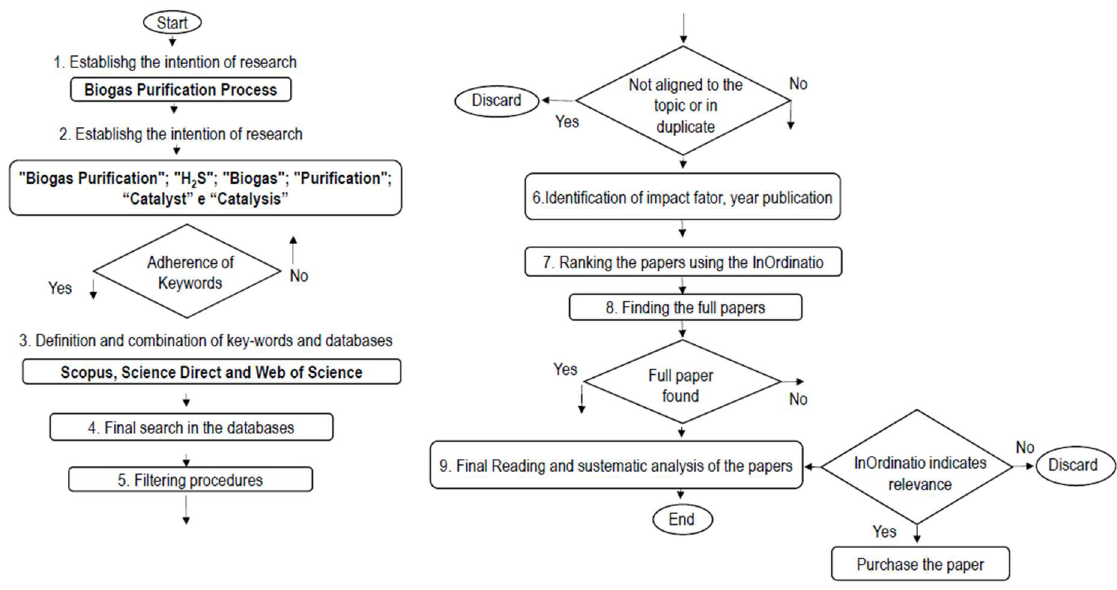
Figure 2. Steps for systematic literature review (adapted from [23]).